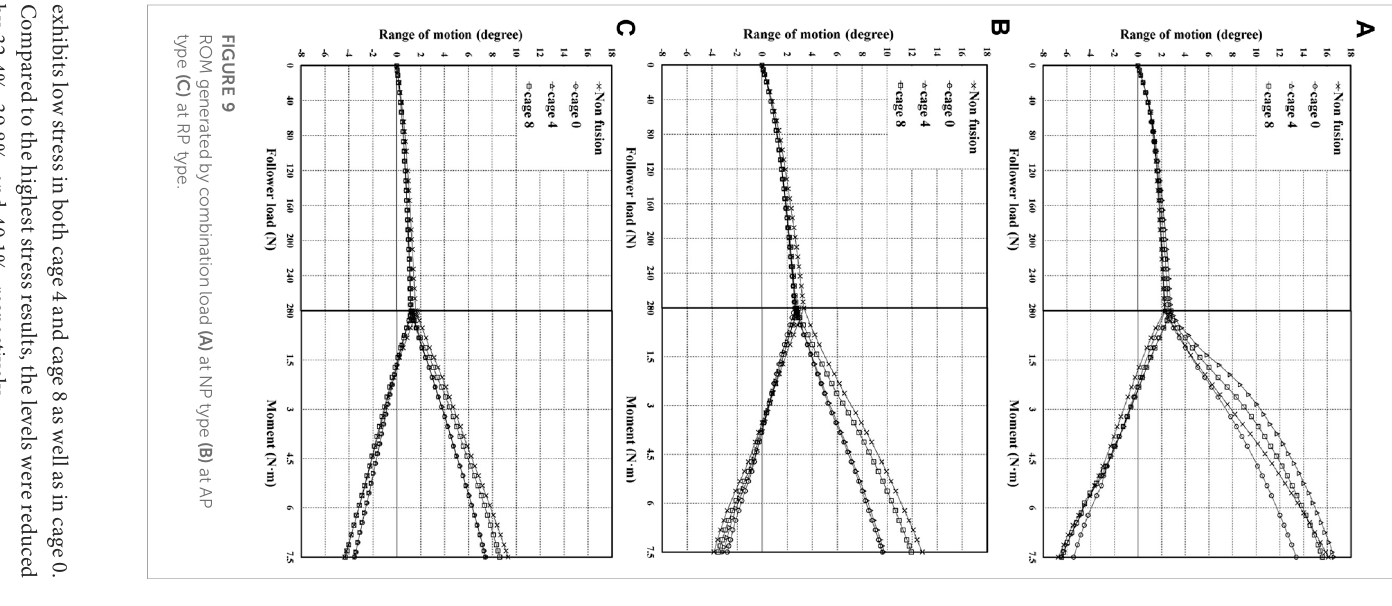
TABLE 3 Lumbar lordosis in non-fusion and fl exion and extension at each cage angle. Pure moment Non-fusion (degree) Cage 0 (degree) Cage 4 (degree) Cage 8 (degree) Natural Flexion Extension Natural Flexion Extension Natural Flexion Extension Natural Flexion